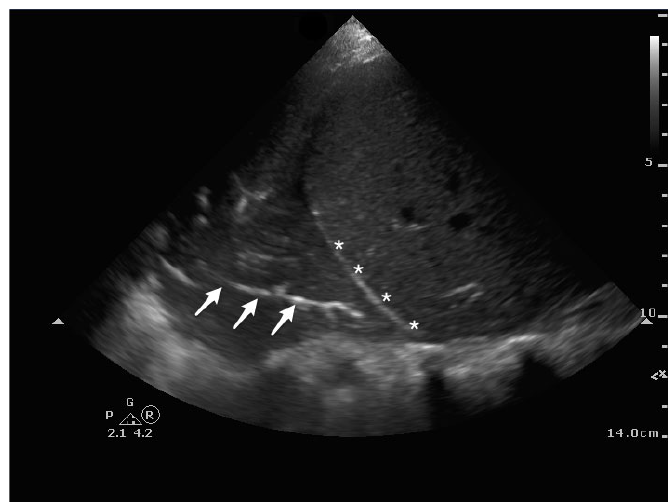
Figure 1a. Ultrasound of lung with pneumonia: Linear, bright (hyper-echoic) foci represent air bronchograms (arrows) above the diaphragm (asterisks).